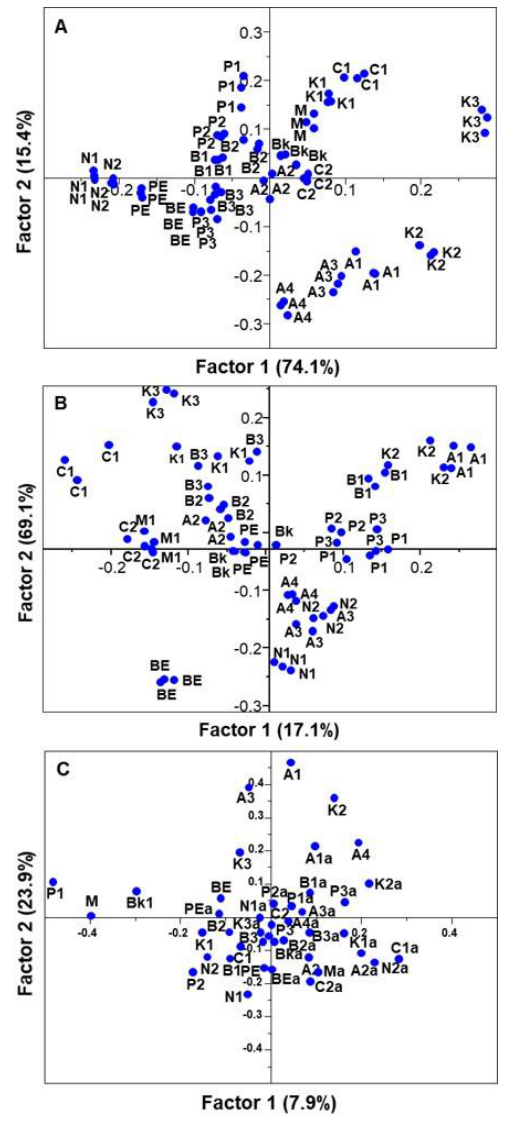
Figure 6. Plot of the scores of phytochemical composition and in vitro antioxidant capacity obtained for the first two factors extracted from the partial least squares (PLS) regressions. ( A ) Triplicates of each sample from 2013, ( B ) triplicates of each sample from 2014, and ( C ) mean of each sample in both years. Cultivars: Arikara yellow (A1, A2, A3, A4), butter bean (B1, B2, B3), cranberry (C1, C2), red kidney (K1, K2, K3), navy (N1, N2), pinto (P1, P2, P3), black (Bk), brown eyed (BE), pink eyed (PE), and tarrestre (M).